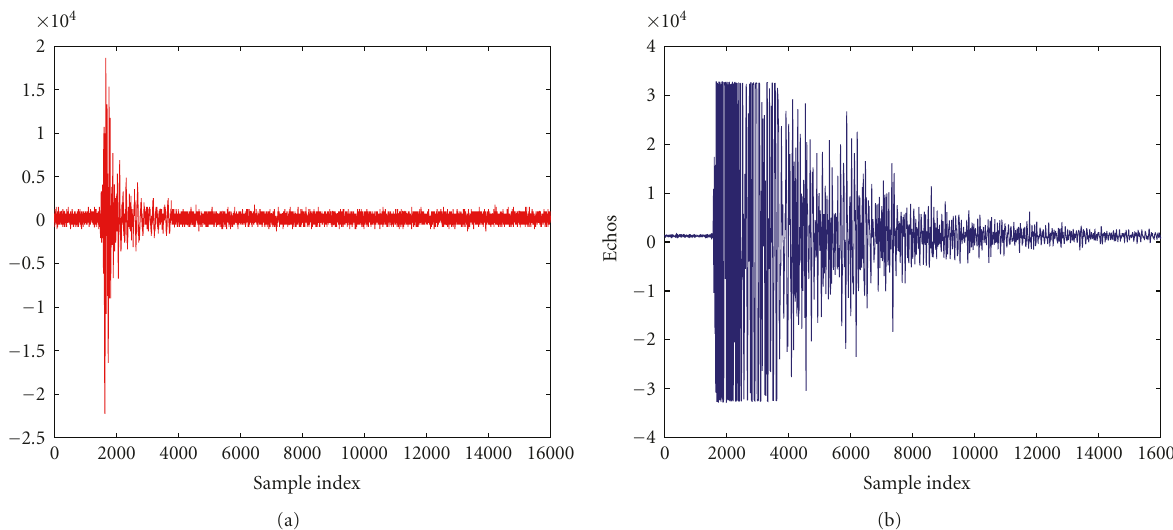
Figure 4: Transmitted pulse and received echos in one experiment. (a) Transmitted pulse. (b) Received